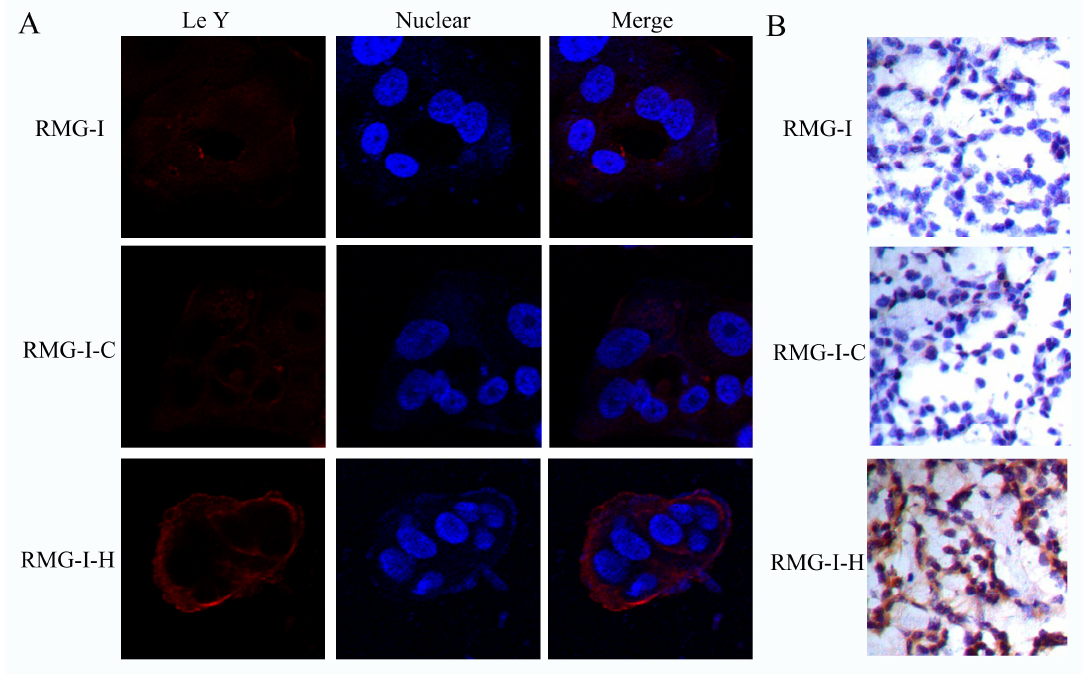
Figure 1. Determination of expression of LeY. ( A ) Cells were fixed and stained for LeY using LeY mAb labeled with Rhodamine (TRITC)-conjugated AffiniPure Goat Anti-Mouse IgG (red). Blue: Nuclei stained with 4,6-diamidino-2-phenylindole (DAPI); ( B ) Immunohistochemistry for LeY in xenograft